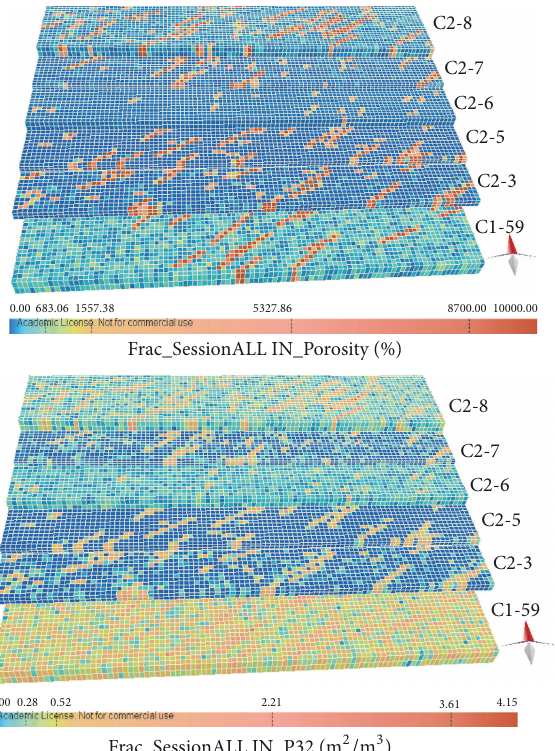
Figure 10: Final model (10000m 2 at the base and height propor- tional to the measured layer thickness) of (a) relative porosity (%) and (b) P32 (m 2 /m 3